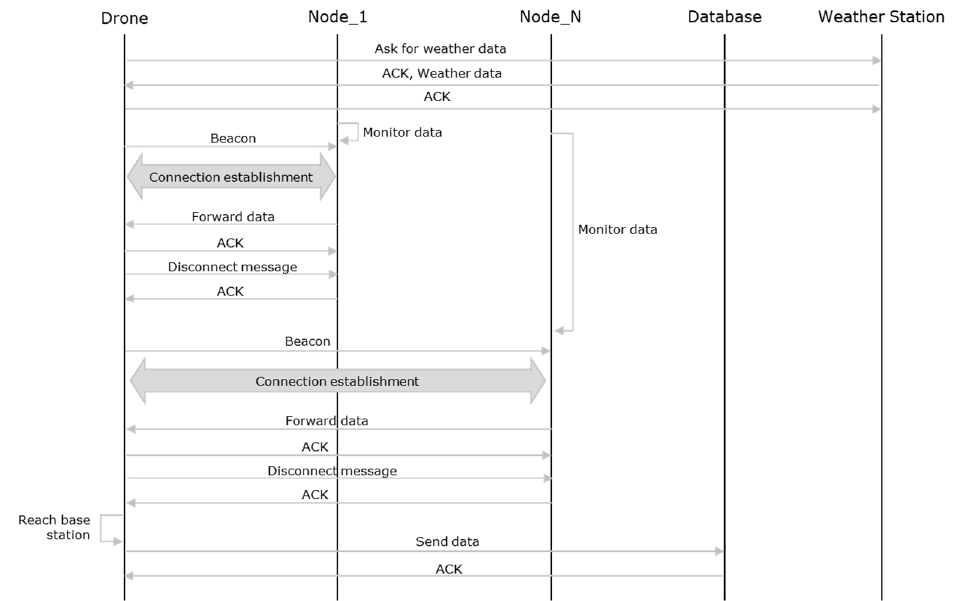
Figure 8. Message exchange between the elements of the architecture.